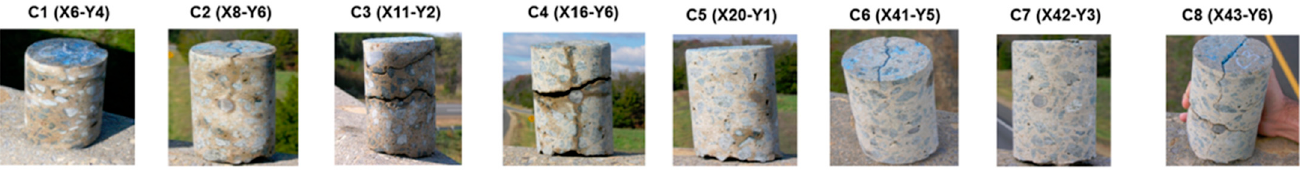
Figure 13. C-scan images for IE data collected from the bridge deck; spectral data are displayed up to 6 kHz. The closed and open circles are the positions of the good and poor cores, respectively. ( a ) Overlapped images of four NDT results analyzed by experts (image courtesy: Taekeun Oh), ( b ) prediction result of the SL model, ( c ) prediction result of the SSL model. Table 3. Comparison of core test and prediction results.